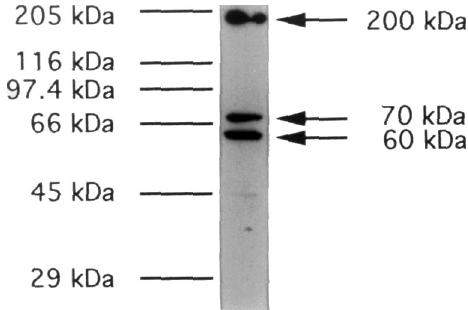
Fig. 2. Western blotting analysis of AS-2 antibody against whole cells extracts of exponentially growing K562. Molecular weight determination was assessed by means of molecular weight markers (range 29–205 kDa). Three reaction bands, indicated by the arrows, have approximate molecular weight of 200, 70 and 60 kDa. Reproducibility of these data was repeatedly tested.